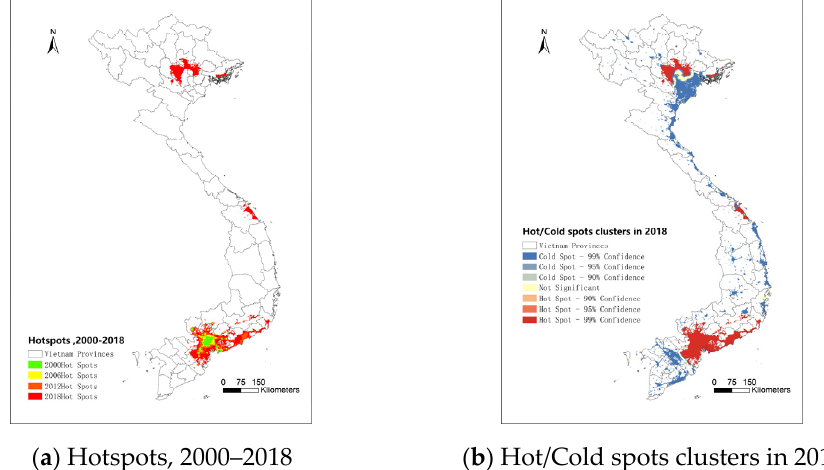
Figure 5. Hotspot clustering and coldspot/hotspot clustering characteristics from 2000 to